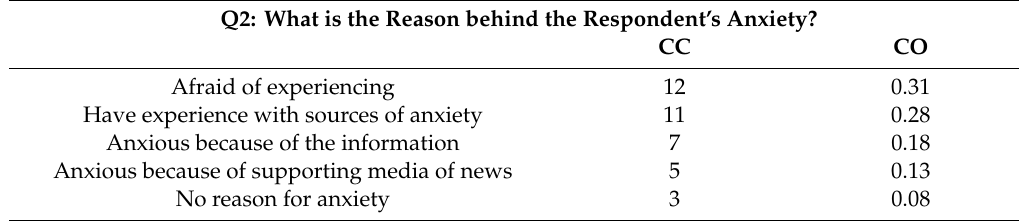
Table 15. Co-occurrences of Question